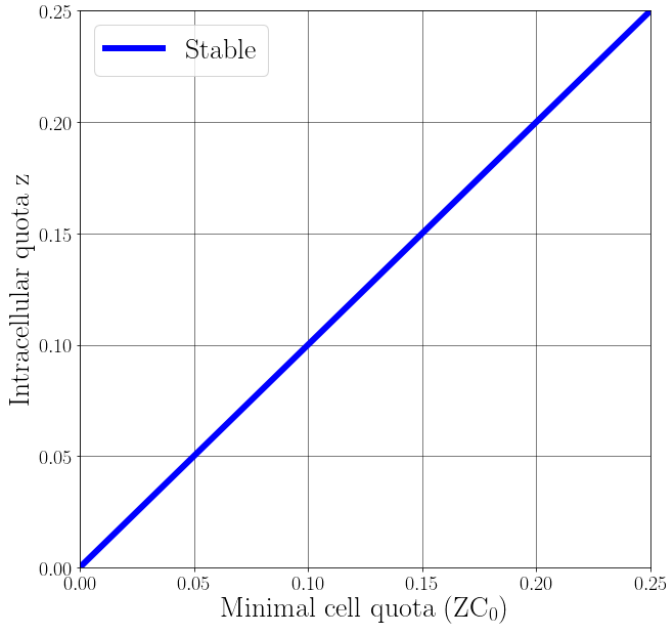
Figure 2. A bifurcation diagram of the intracellular quota z vs. minimal cell quota zc 0 . For each value of zc 0 , the diagram shows the corresponding equilibrium points. We prepared the plot in Python 3.7.1.